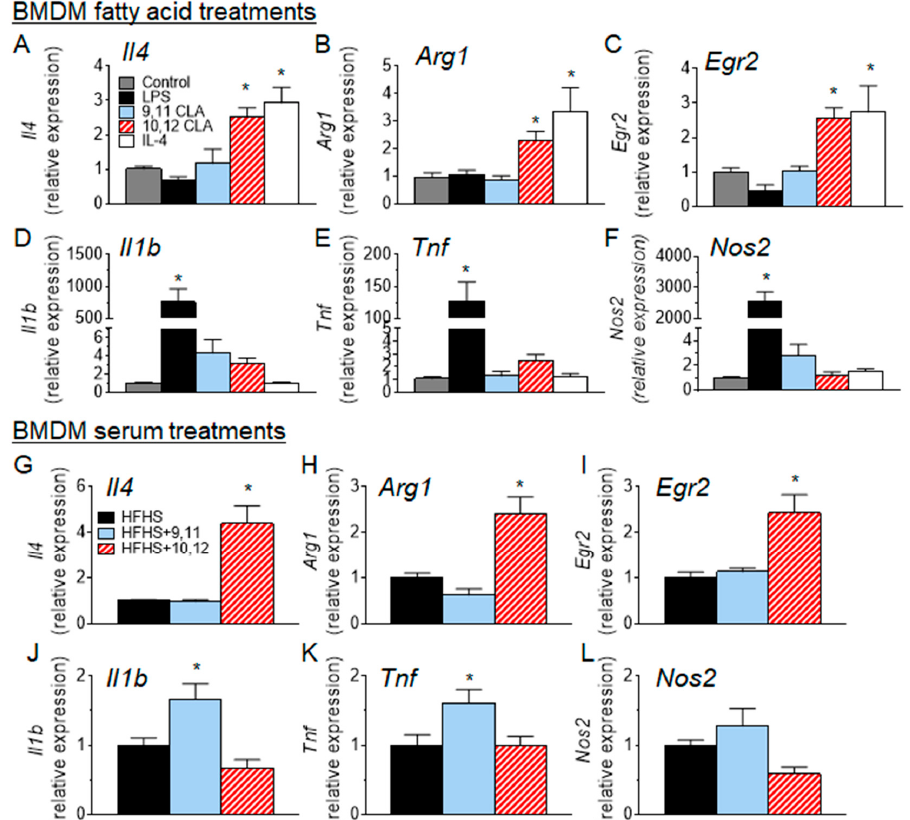
Figure 5. 10,12 CLA promotes the alternative polarization of macrophages in vitro. ( A – F ) bone marrow-derived macrophages (BMDMs) were treated with media alone (control), lipopolysaccharides (LPS) (10 ng/mL for 4 h), interleukin-4 (IL-4) (10 ng/mL for 24 h), or 10,12 CLA (100 µM for 24 h). ( G – L ) BMDMs were treated for 24 h with 10% serum isolated from mice fed a HFHS diet with or without 1% 9,11 or 10,12 CLA. Total RNA was extracted from >1 × 10 6 macrophages and reverse transcribed for real-time quantitative polymerase chain reaction (RT-PCR) analysis. n = 3; data are presented as mean ± SEM. * p < 0.05 from media or HFHS control.